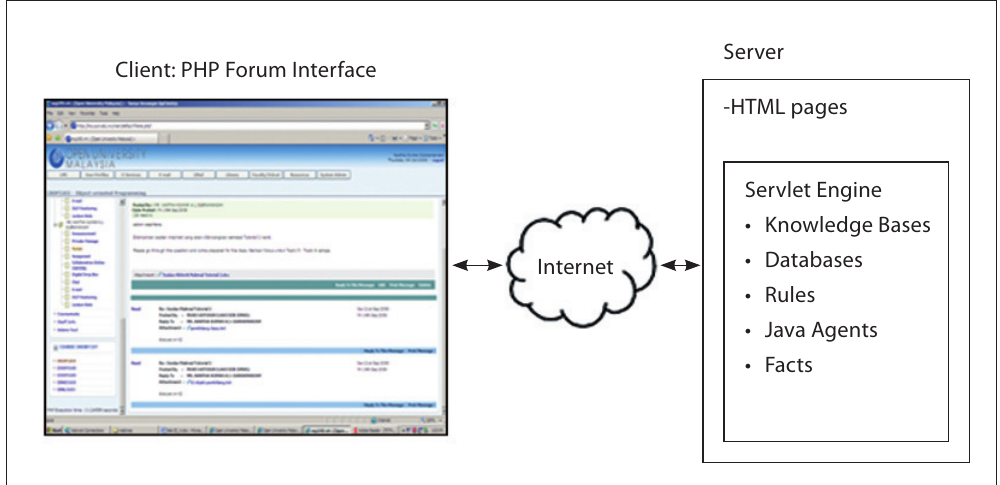
Figure 1 General overview of a smart